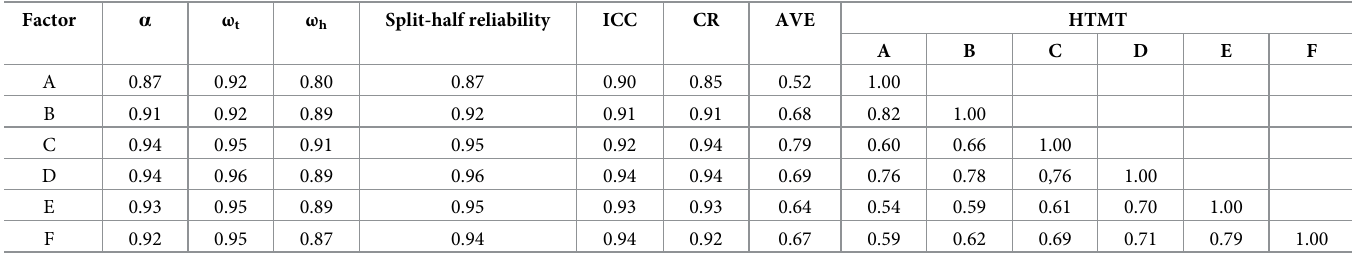
Average Variance Extracted, HTMT: Heterotrait-Monotrait ratio of correlations Factor A: Physical working conditions , Factor B: Work nature , Factor C: Income and other benefits , Factor D: Management policies and managers , Factor E: Relationships with coworkers and customers , Factor F: Learning and advancement opportunities . ICC: p-values for all factors <